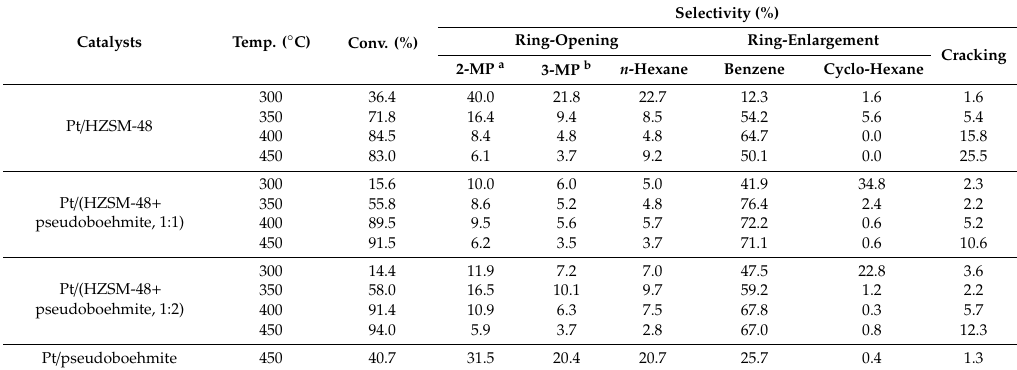
Table 3. Conversion and selectivity in methylcyclopentane reforming over various catalysts